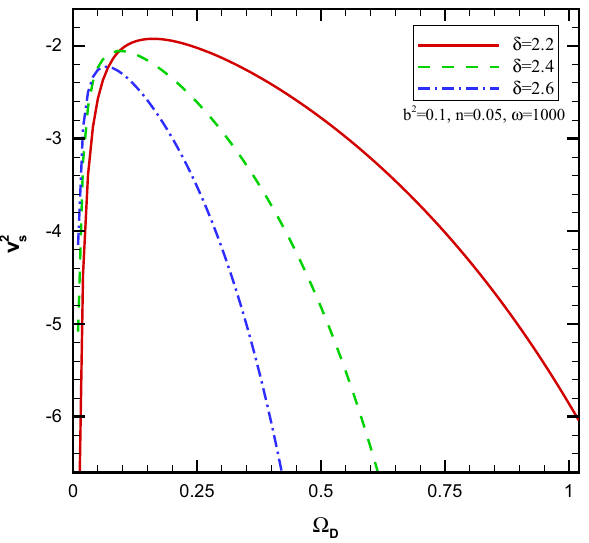
Fig. 10 v 2 s versus (cid:3) D for the sign-changeable interacting THDE with theHubblecutoff,where (cid:3) k 0 = 0 . 1, b 2 = 0 . 1, n = 0 . 05and ω = 1000 are